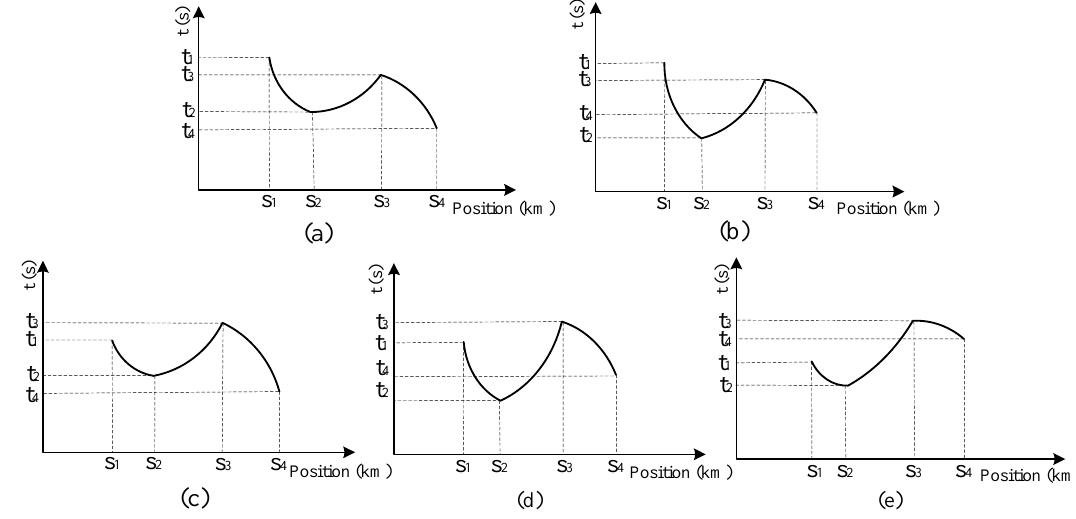
Figure 5. Five typical scenarios of the running time t 1 , t 2 , t 3 and t 4 . ( a ) t 1 > t 3 > t 2 > t 4 ; ( b ) t 1 > t 3 > t 4 > t 2 ; ( c ): t 3 > t 1 > t 2 > t 4 ; ( d ) t 3 > t 1 > t 4 > t 2 ; ( e ) t 3 > t 4 > t 1 > t 2